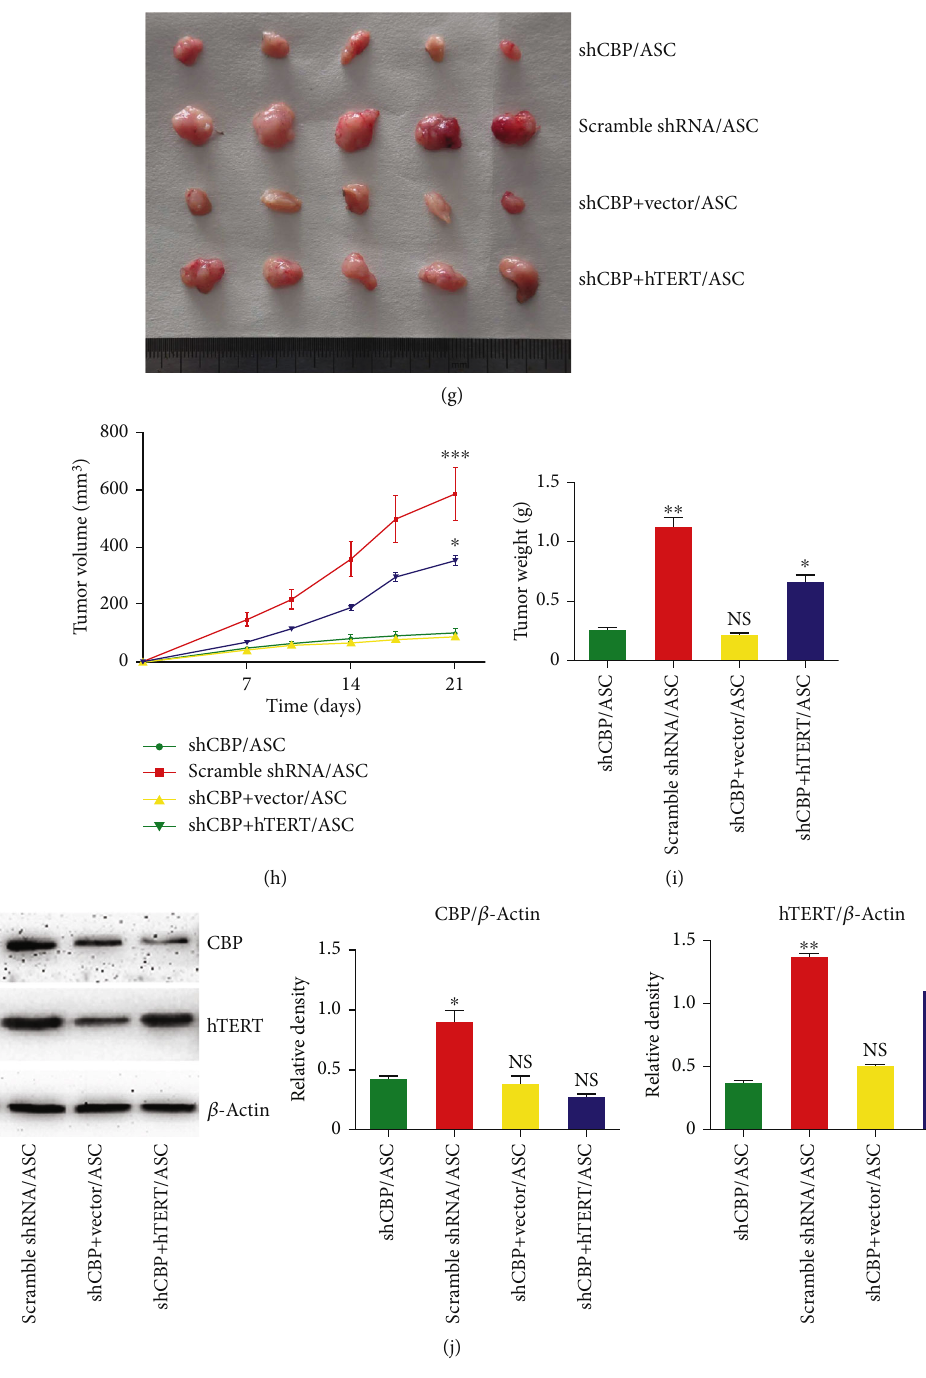
Figure 4: Inhibition of CBP and RFPL-3 suppresses the proliferation of breast cancer cells with cocultured ASCs following decreases in hTERT transcription in vitro and in vivo. (a) Real-time PCR and western blot analysis of the expression of hTERT mRNA and protein in MDA-MB-231 cells transfected with CBP siRNA and nonspeci fi c siRNA. (b – c) The transfected MDA-MB-231 cells were treated with culture supernatant from ASCs, and the cell viability and proliferation were analyzed using CCK-8 assays and dsDNA quanti fi cation. (d) MDA-MB-231 cells were transfected with RFPL-3 siRNA and nonspeci fi c siRNA, and then, hTERT mRNA and protein were examined using real-time-PCR and Western blot. (e – f) MDA-MB-231 cells transfected as above were treated with culture supernatant from ASCs, and then, the cell viability and proliferation were examined by CCK-8 assays and dsDNA quanti fi cation. (g) Tumor grafts up to 21 days after nude mice were injected with ASCs and cell lines stably expressing CBP shRNA, scramble shRNA, CBP shRNA + empty vector, and CBP shRNA + hTERT. (h) Tumor growth curves in nude mice. (i) The mean tumor weights 21 days after coinjection. (J) Western blot analysis of the expression of CBP and hTERT in tumor xenografts. ∗ P < 0 : 05 , ∗∗ P < 0 : 01 , ∗∗∗ P < 0 : 001